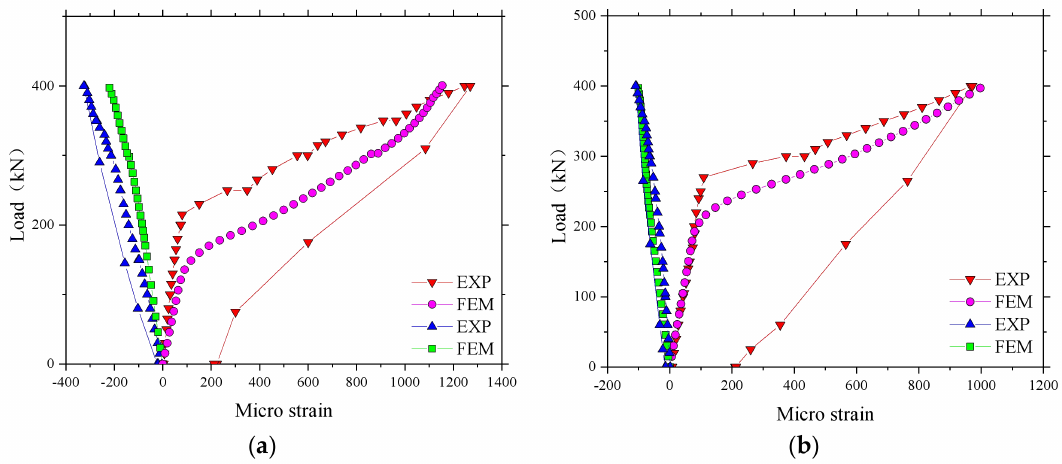
Figure 17. Comparison of load–strain responses obtained from the experimental test and the FEM. ( a ) Loading between the W-beams; ( b ) Loading between W-beams and